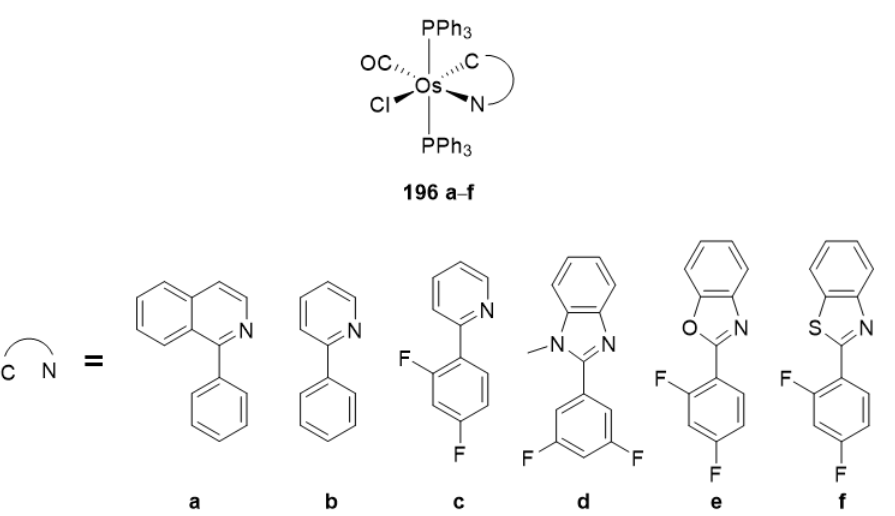
Figure 50. Luminescent [OsCl(N~C)(PPh 3 ) 2 (CO)] complexes. Bis -(P~C~P) pincer osmium complex 39 (Figure 10) has a strong absorption at 250 nm 2- MeTHF at 77 K with a quantum yield of 0.6 and a lifetime of 8.0 μs suggests phospho-